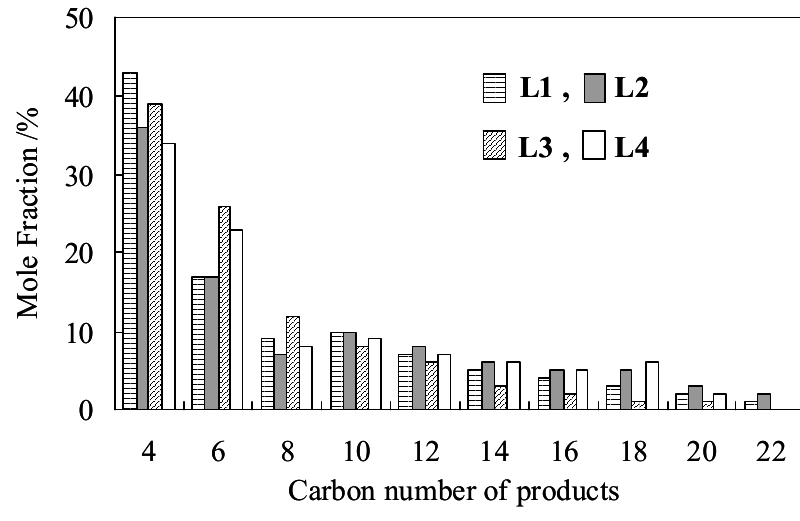
Figure 2. Distribution of products from ethylene oligomerization using L1–4 /Ni 2+ -Mica procatalyst. Reaction conditions are the same as in Table 1.